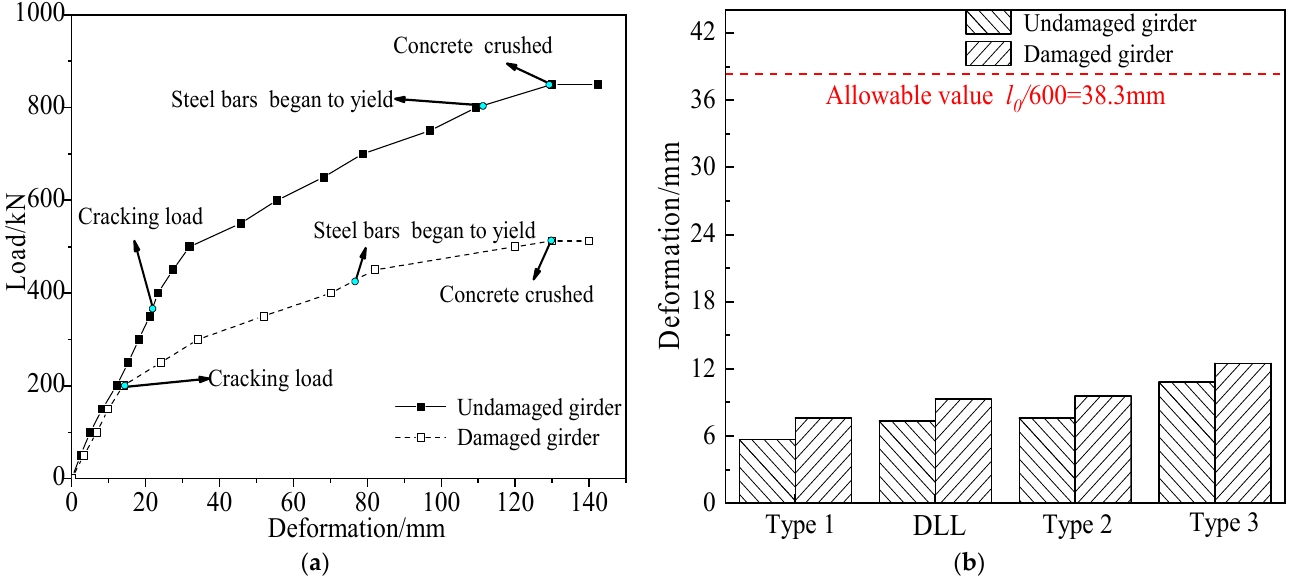
Figure 23. Midspan deformation comparison due to the destructive tests ( a ) Load vs. deformation curve; ( b ) Midspan deformation under different live loads.